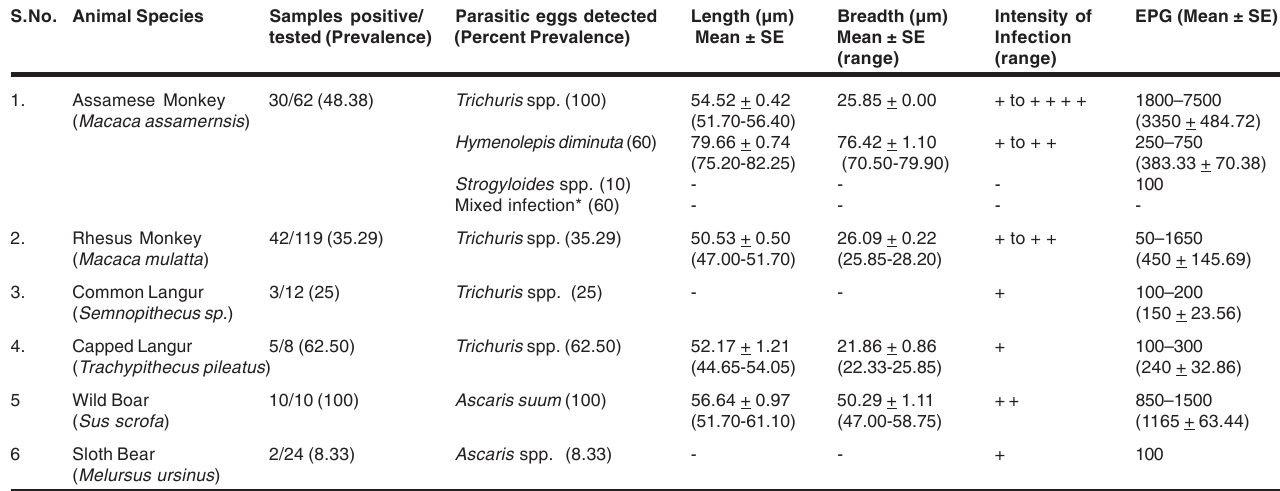
Table 1. Mean micrometric readings of eggs and intensity of parasitic